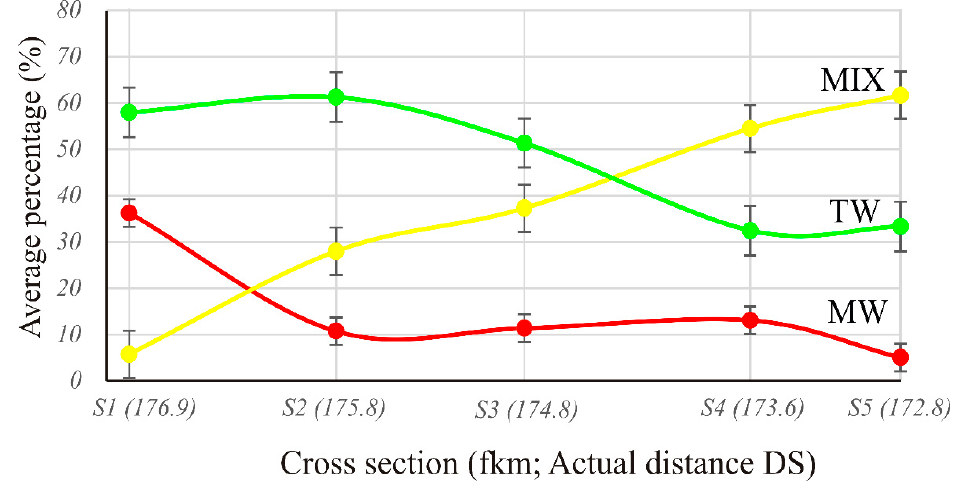
Figure 6. The mean percentage of the Tisza water (TW), Maros water (MW) and their mix (MIX) along five cross sections downstream of the confluence point based on the acquisition of 143 sentienl-2 images. The error bars indicate a 95% confidence interval.